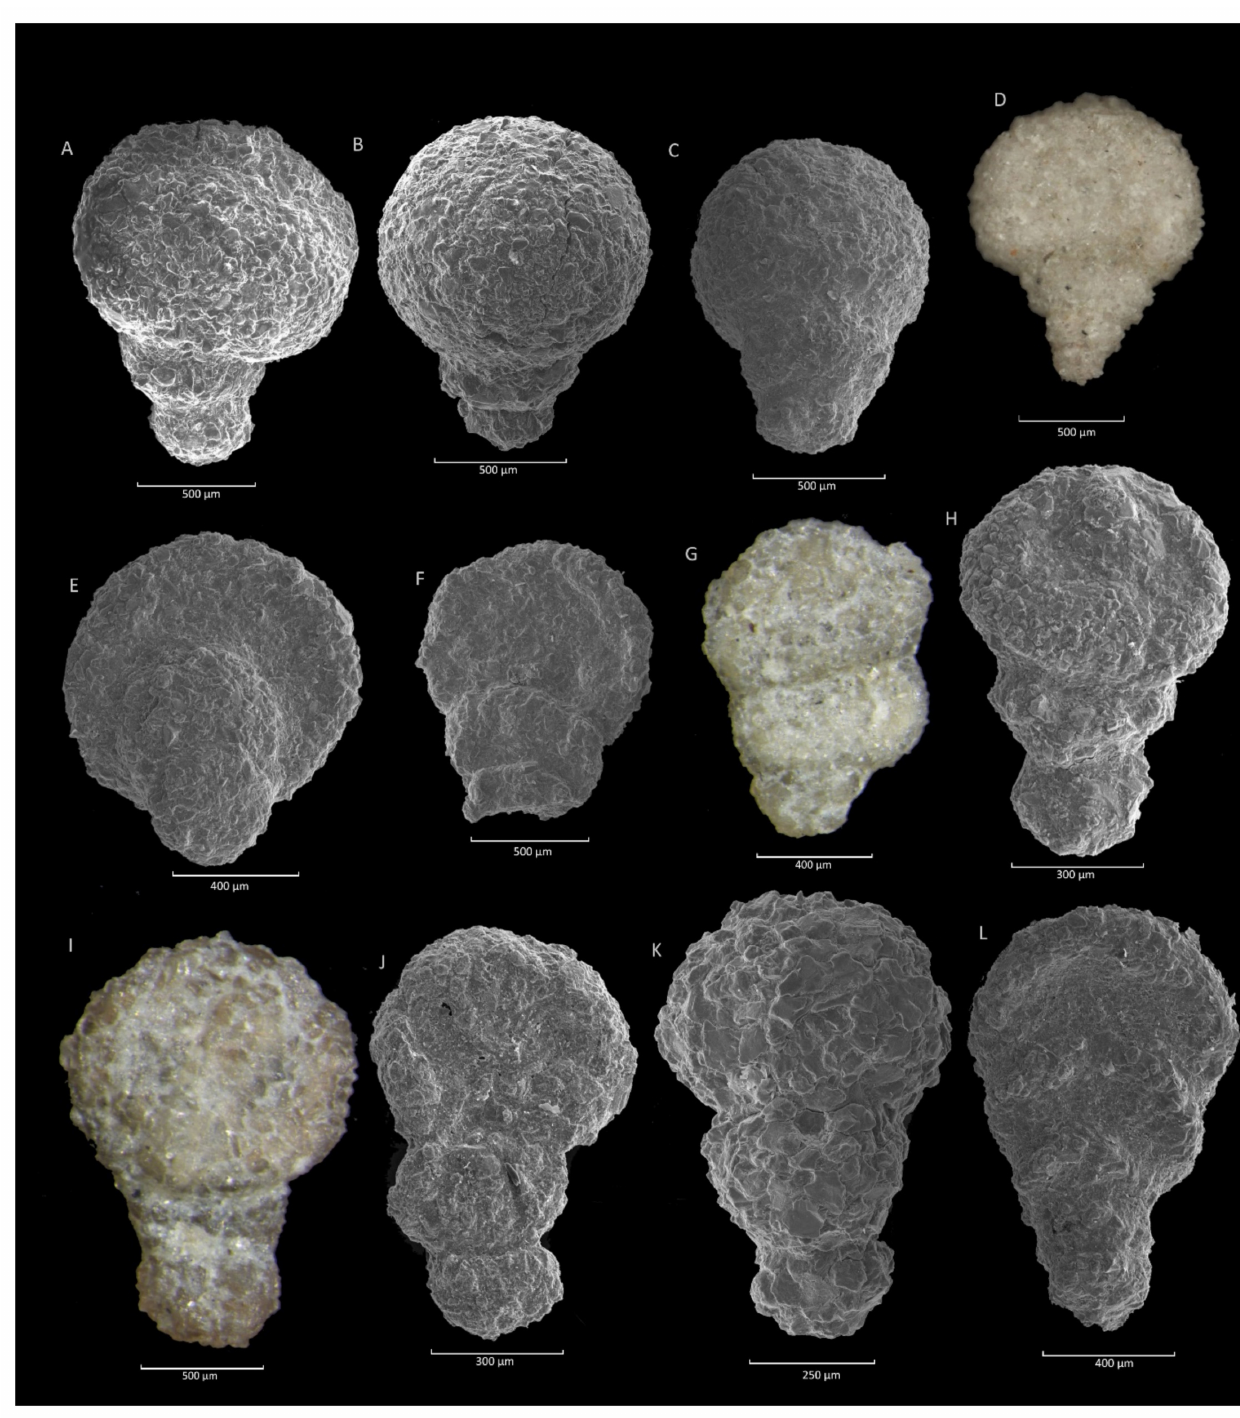
Figure 16. Reophax pilulifer type group. Reophax “pilulifer ” Brady. ( A , B ): Krzesławice section; ( C ): Sucha Beskidzka